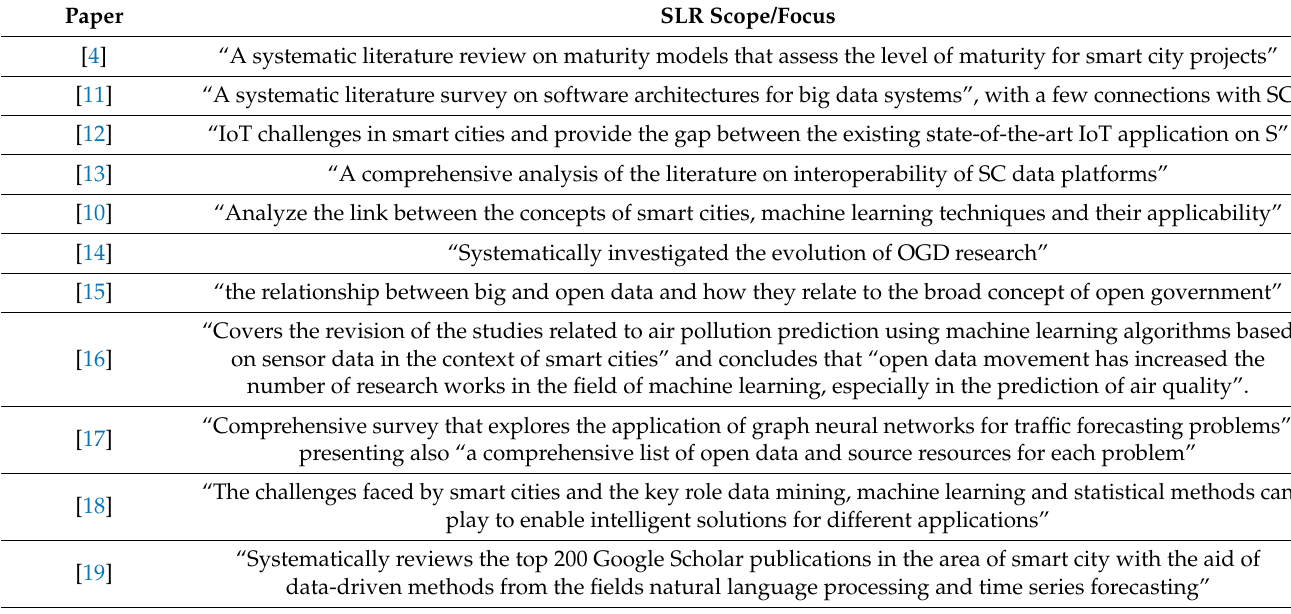
Table 1. Related SLR